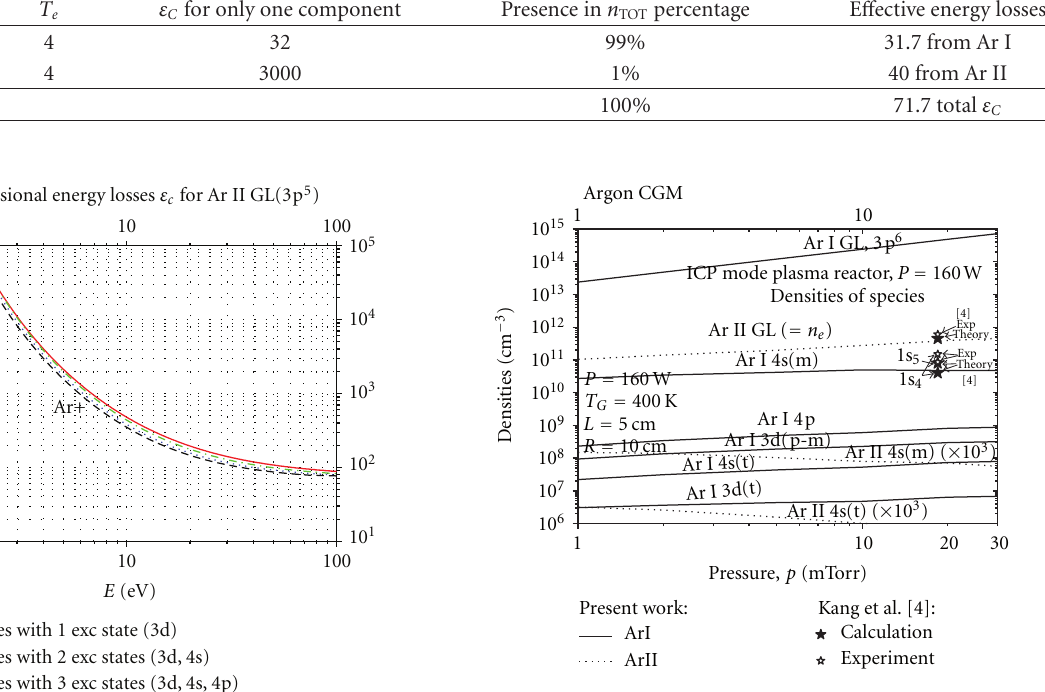
Figure 4: Plasma reactor calculated densities of Ar I GL, Ar I excited species, Ar II GL, and Ar II 4s(m), 4s(t) species. Pressure varies from 1mTorr to 30 mTorr; (m) = metastable, (t) = transitory, (p-m) =